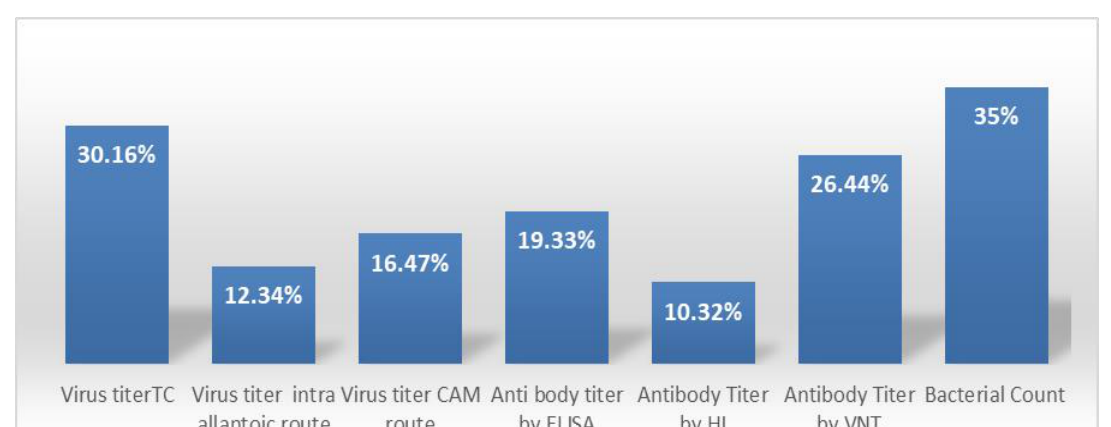
Fig.7: Measurement uncertainty for different 7 methods applied in